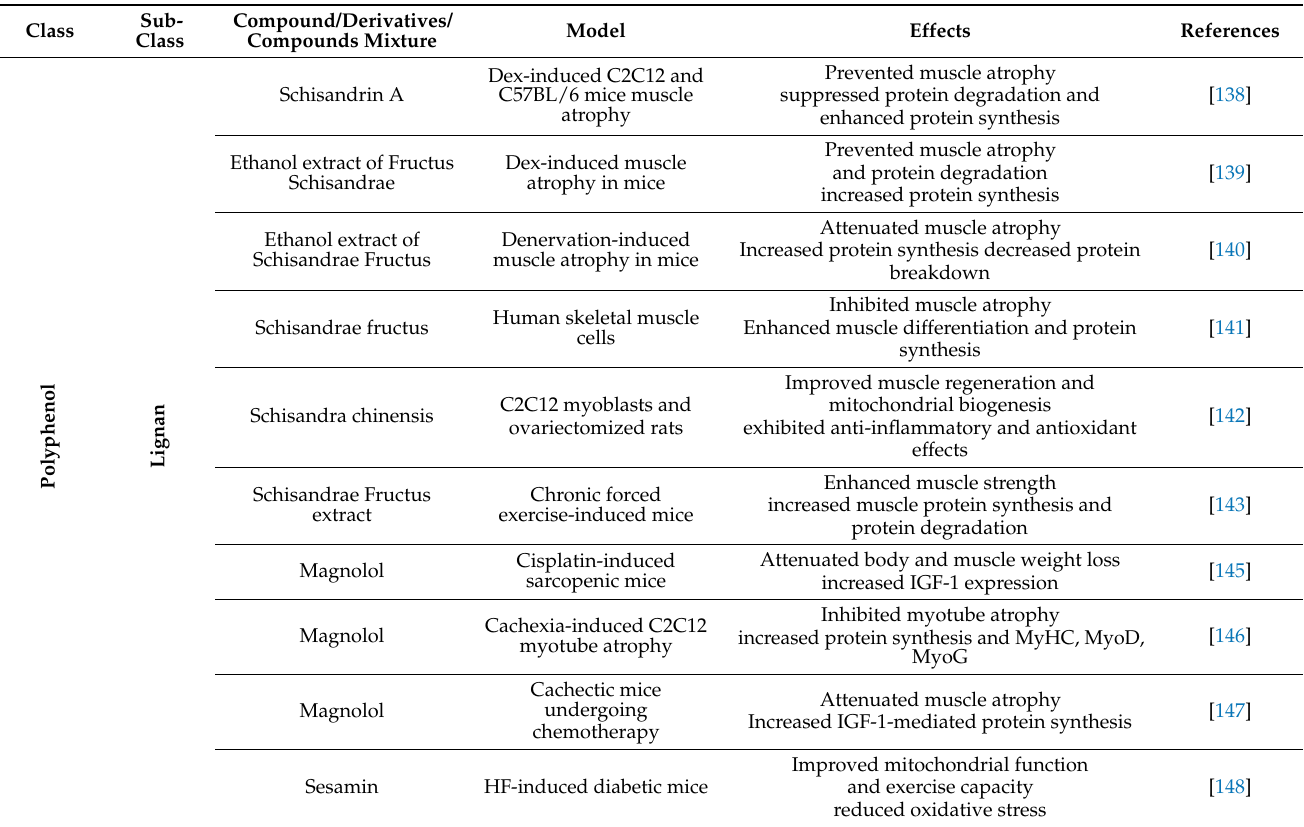
Table 4. Function of lignan and its derivatives in promotion of muscle health and prevention of muscle